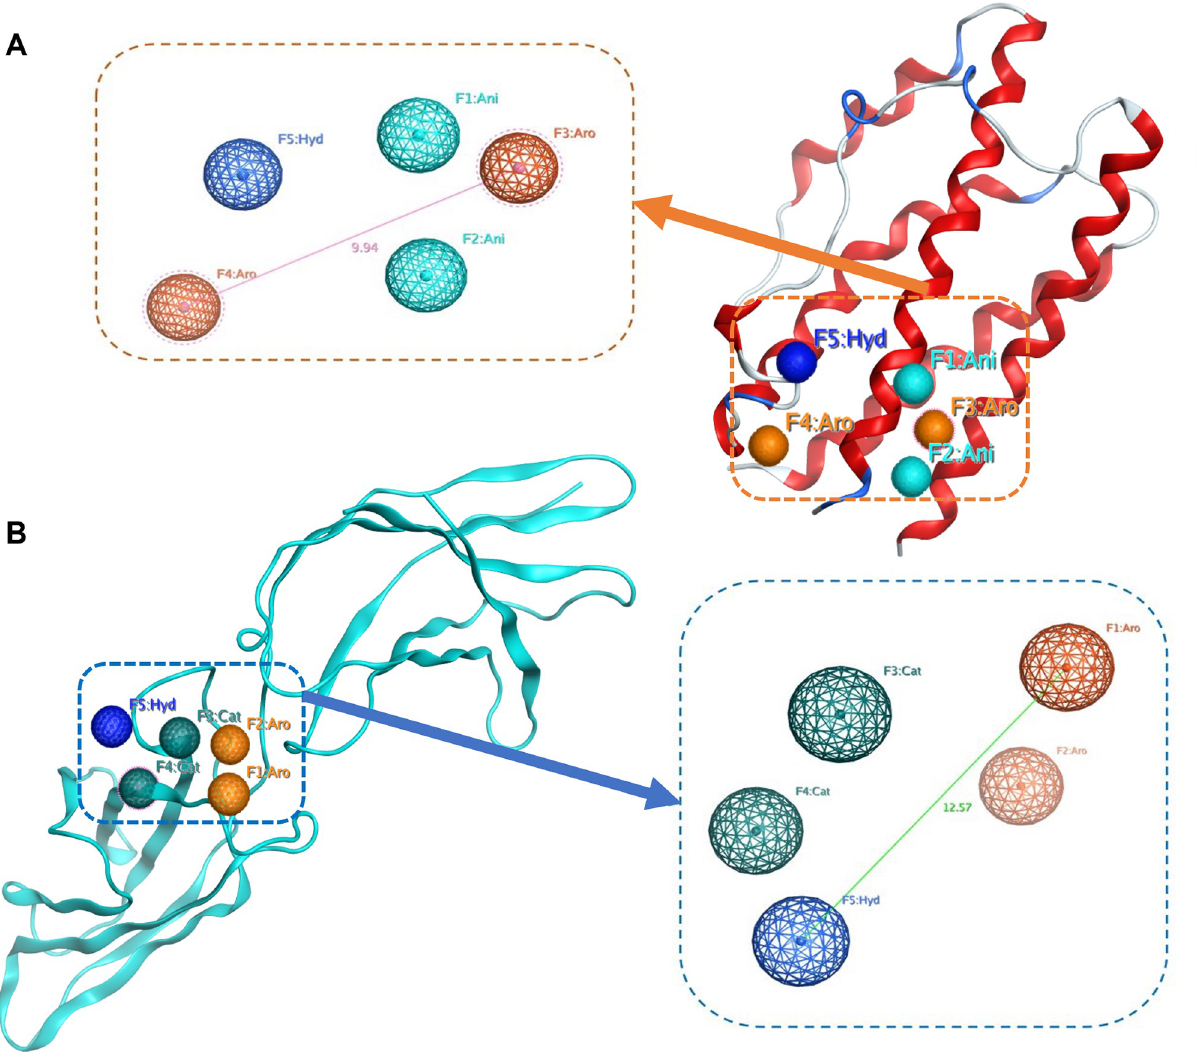
Fig 2. The pharmacophore models built based on PPI approach are mapped on IL-6 (Ph_1, A) and IL-6R α (Ph_2, B) structures. Each sphere represents an abbreviated pharmacophore feature: Cat is cation atom (in dark green), Ani is anion atom (in cyan), Hyd is hydrophobic (in dark blue) and Aro is an aromatic ring (in orange). The pink and green lines represent the largest distance ( Å ) between pharmacophore points.